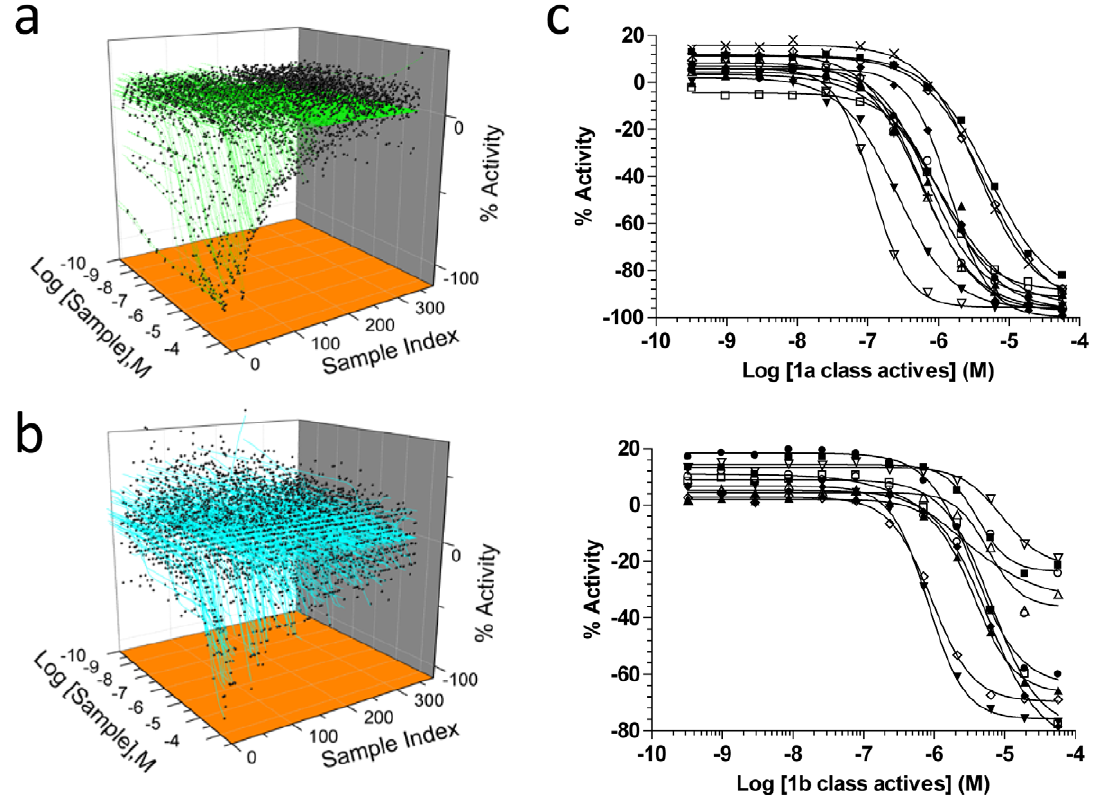
Figure 1. qHTS Profiling of GSK PKIS. ( a ) qHTS 3-axis plot of GSK PKIS activity against FLuc. ( b ) Same as a. except for RLuc. ( c ) Compounds in top panel display high quality curve fits (r 2 . 0.9) fully titrating FLuc activity from 0% inhibition to 100% relative to a PTC124 control inhibitor. Those in the lower panel differ from the top group because the FLuc activity is not completely titrated compared to control (see Efficacy in Table 2 ). Compounds in curve class 1b typically display apparent incomplete titration of activity possibly due to not achieving a concentration for complete inhibition ( , 10 6 IC 50 ), or limiting solubility of the compound at the higher concentrations.